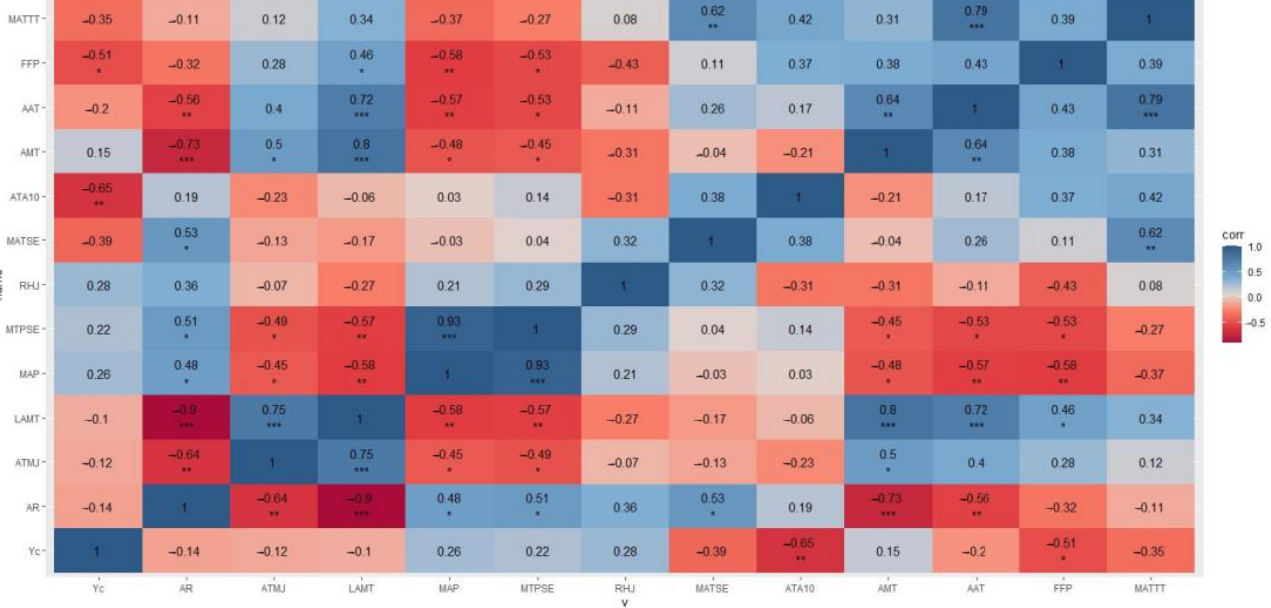
Table 2. Analysis of variance between meteorological yield and 12 meteorological factors. Analysis of Variance df SS MS F Significance F Regression Analysis